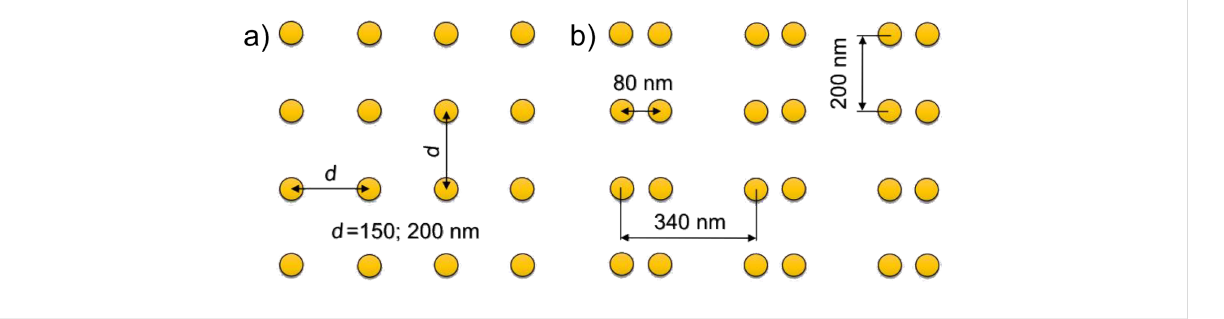
Figure 1: A sketch representing (a) a regular Au nanocluster array and (b) a Au dimer array.